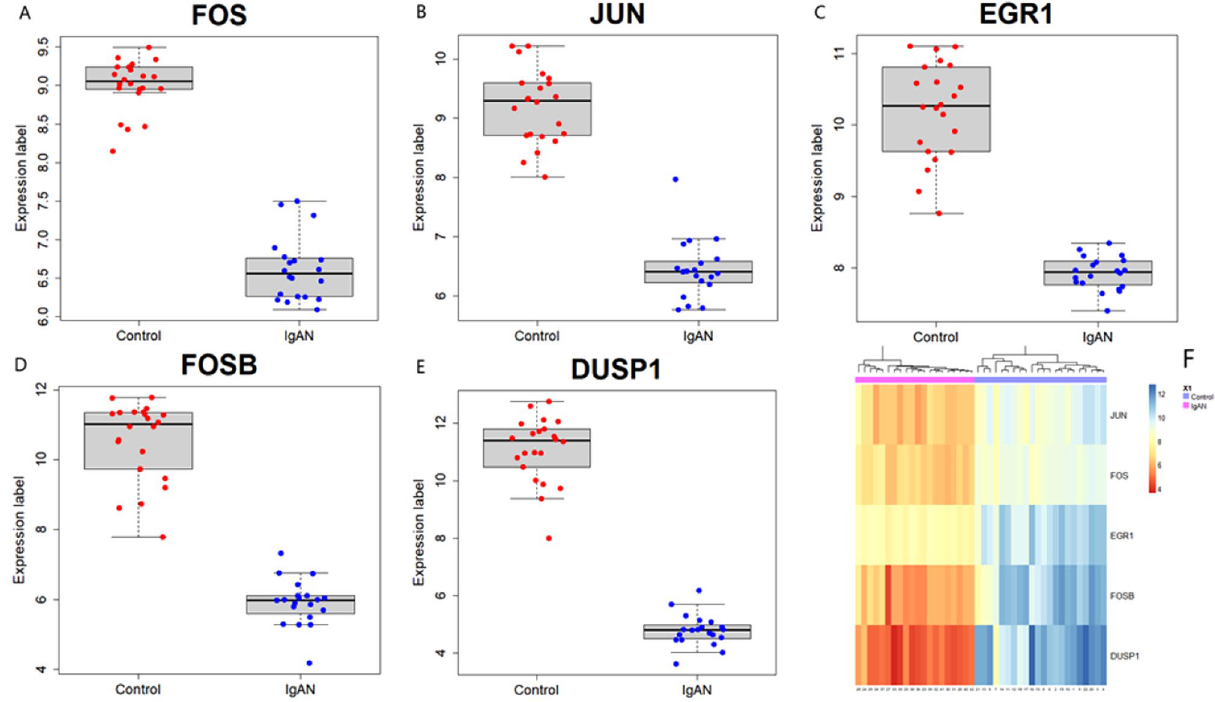
Figure 8. Boxplot of five key candidate genes as ( A ) FOS, ( B ) JUN, ( C ) EGR1, ( D ) FOSB, ( E ) DUSP1 for IgAN patients, and ( F ) Heatmap of the five key candidate genes in renal tissue samples which were generated using “NMF” version 0.24.0 package in R 64 (https:// cran.r- proje ct. org/ packa ge=